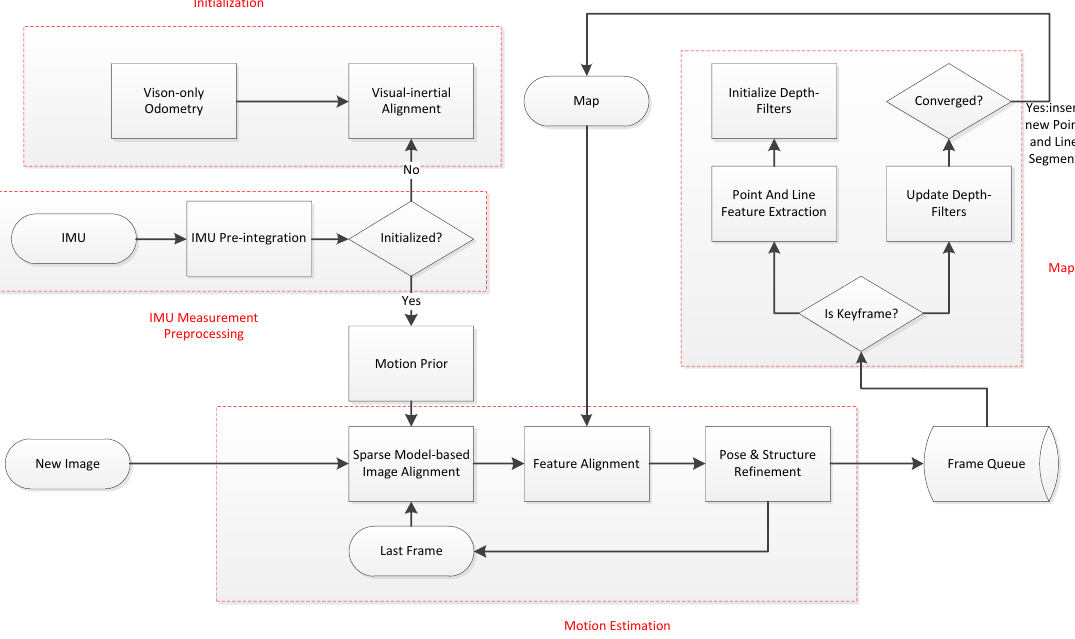
Figure 1. Flow chart of the proposed